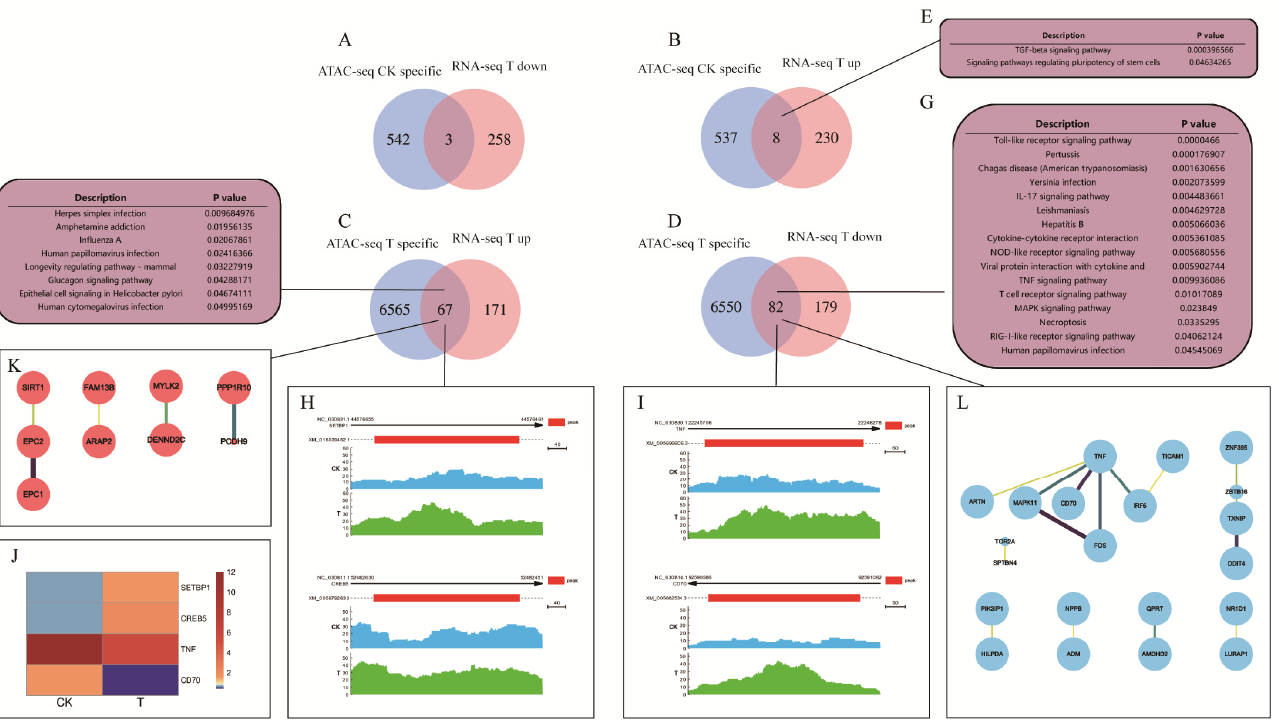
Figure 9. Identification of the regulatory DNA elements in the different groups. ( A – D ) Venn overlap of the differential peak-associated genes identified by ATAC-seq and the DEGs detected by RNA-seq. ATAC-seq T specific: T group-specific peak-related genes; ATAC-seq CK-specific: CK group-specific peak-related genes; RNA-seq T down: DEGs downregulated in the T group based on RNA-seq; RNA- seq T up: DEGs upregulated in the T group based on RNA-seq. ( E – G ) The significantly enriched KEGG pathways for the overlapped genes involved in the host immune response. ( H , I ) Peak diagram showing the genes in the chromatin open regions of the proximal promoter (2 kb) of genes (SETBP1, CREB5, TNF, and CD70). ( J ) Heatmap of the expression level of four genes (SETBP1, CREB5, TNF, and CD70) based on RNA-seq. ( K , L ) Protein–protein interaction network of the 67 and 82 overlapped genes. The upregulated genes are colored red, and the downregulated genes are colored green. The depth of the line represents the degree of association, and the size of the dot represents the significance of the p